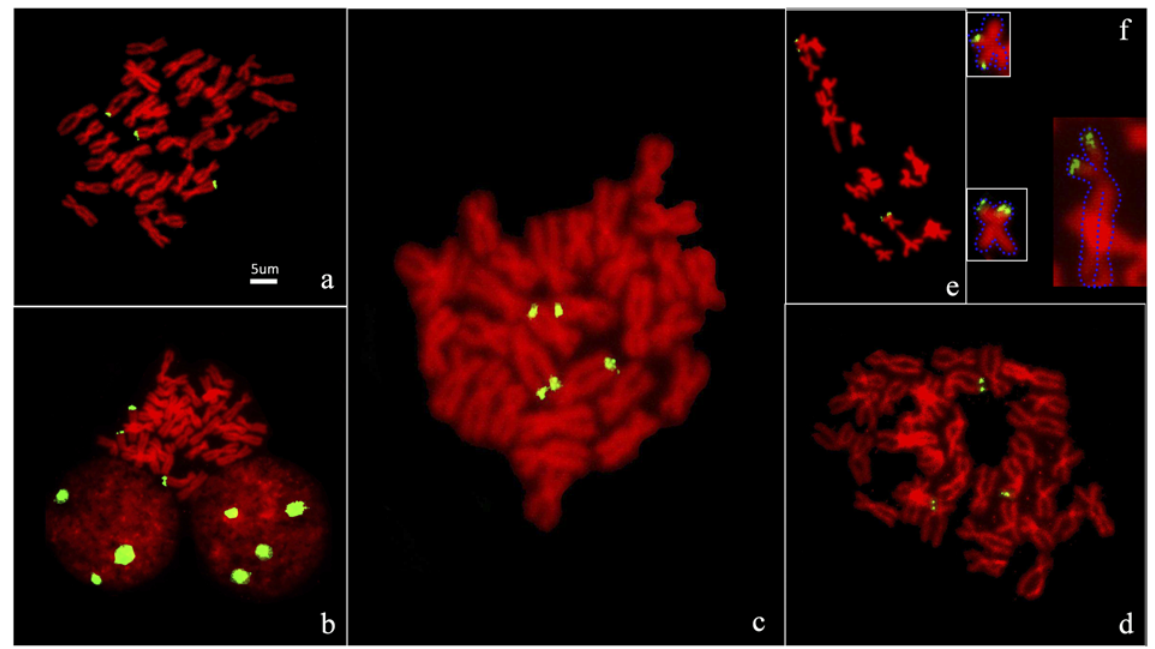
Fig 2. 18S rDNA location on chromosome of H. discus hannai . a: Three rDNA signals on H. discus hannai chromosomes. b: 3 rDNA signals on chomosomes and signals on interphase cells with 3 and 4 nucleoli. c: The common type of rDNA location on chromosomes pairs 14 and 17. d: The rare type of rDNA location on chromosomes short arm in metaphase. e&f: strong signals terminally on the short arms of both m and sm chromosomes. (FITC shown as yellow/green color, PI shown as red color and the blue dashed line in order to better display the outline of chromosome diagrammatically.